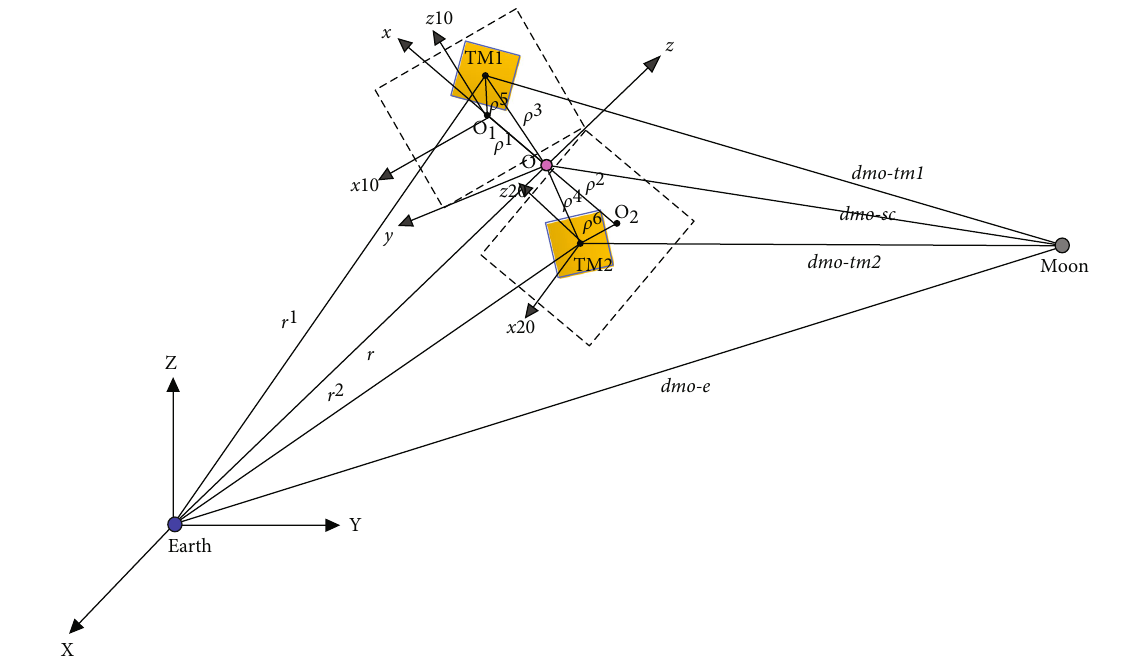
Figure 1: The relative motion between the test masses and the drag-free spacecraft. Table 1: The parameters of the sun orbit and Earth orbit [25]. Orbit parameters Sun